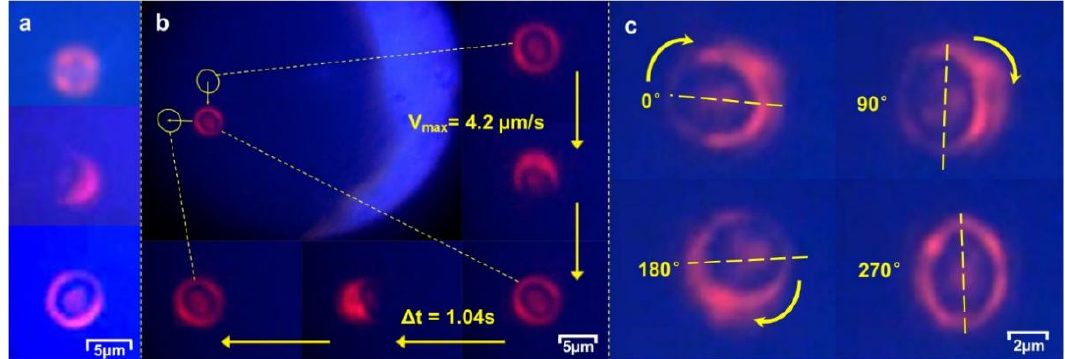
Figure 7. Microscopic images. ( a ) LP 21 beam spots before and after capturing a yeast cell; ( b ) Orientation-maintained transport; ( c ) Controlled rotation of single yeast cells using an LP 21 mode field.